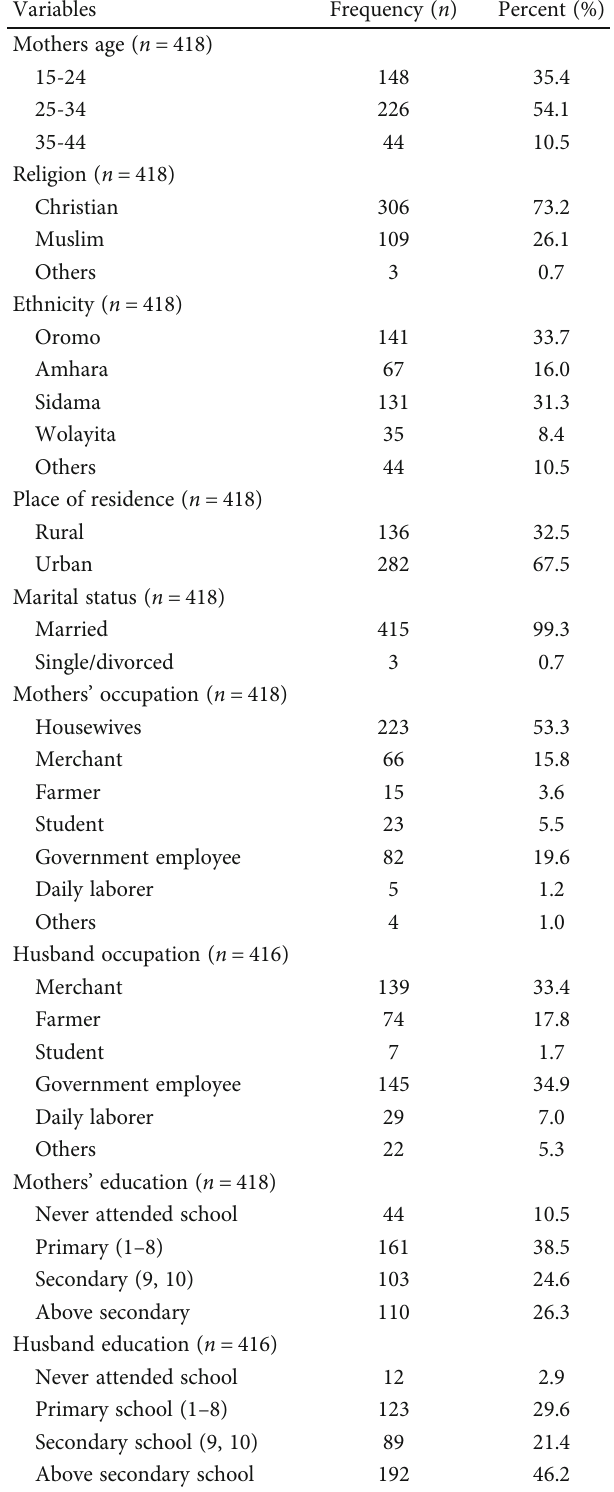
Table 1: Sociodemographic characteristics of mothers who gave birth at HUCSH, Hawassa, Ethiopia, April